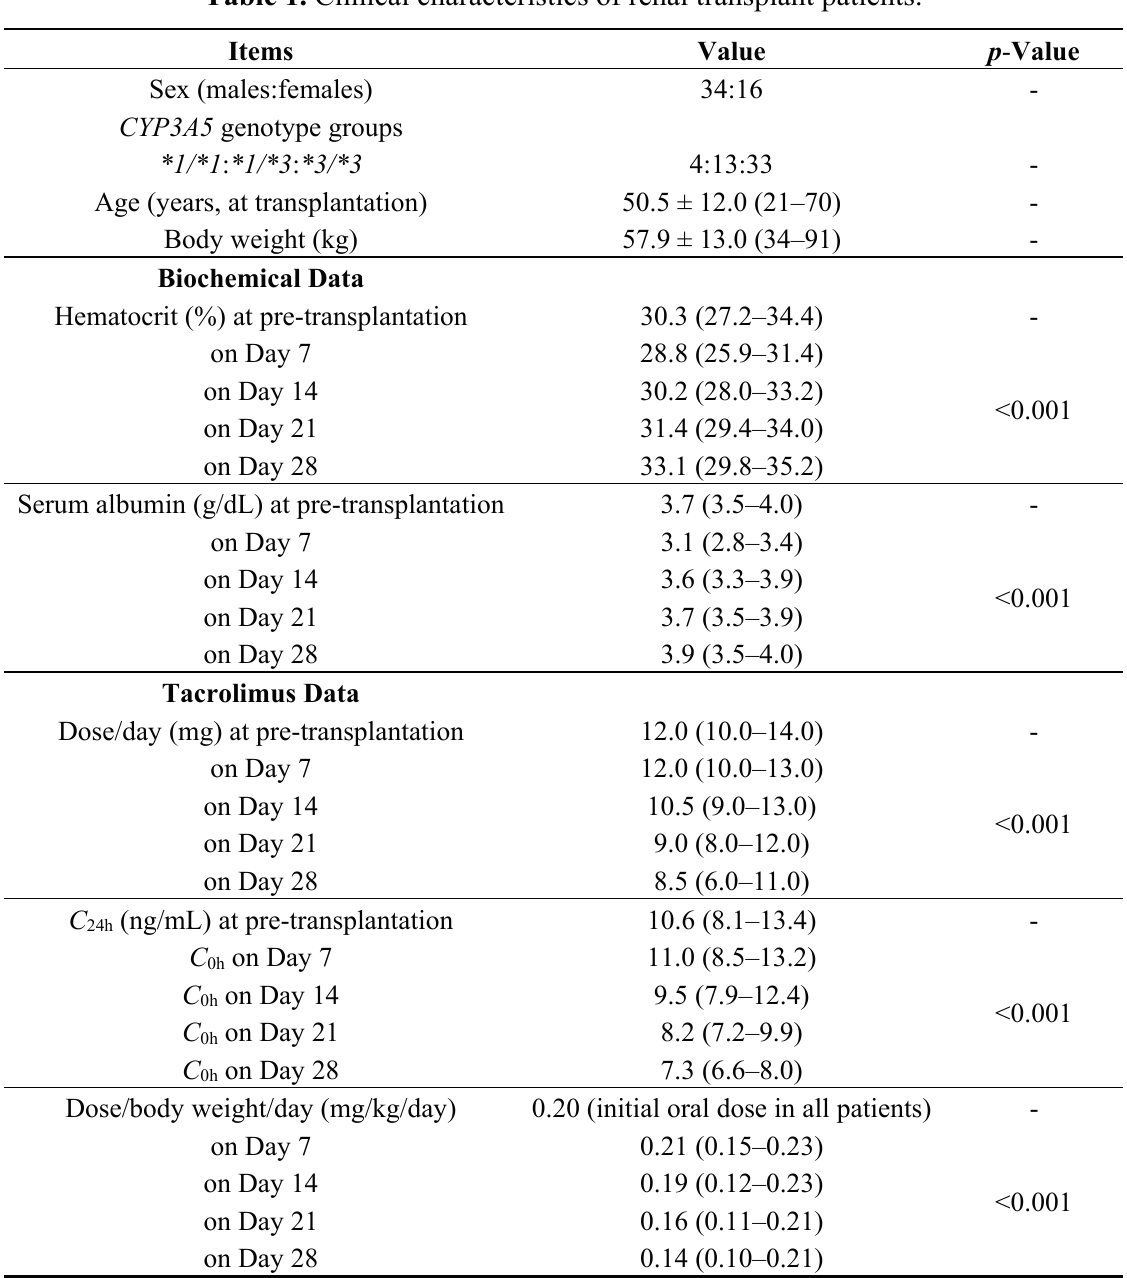
Table 1. Clinical characteristics of renal transplant